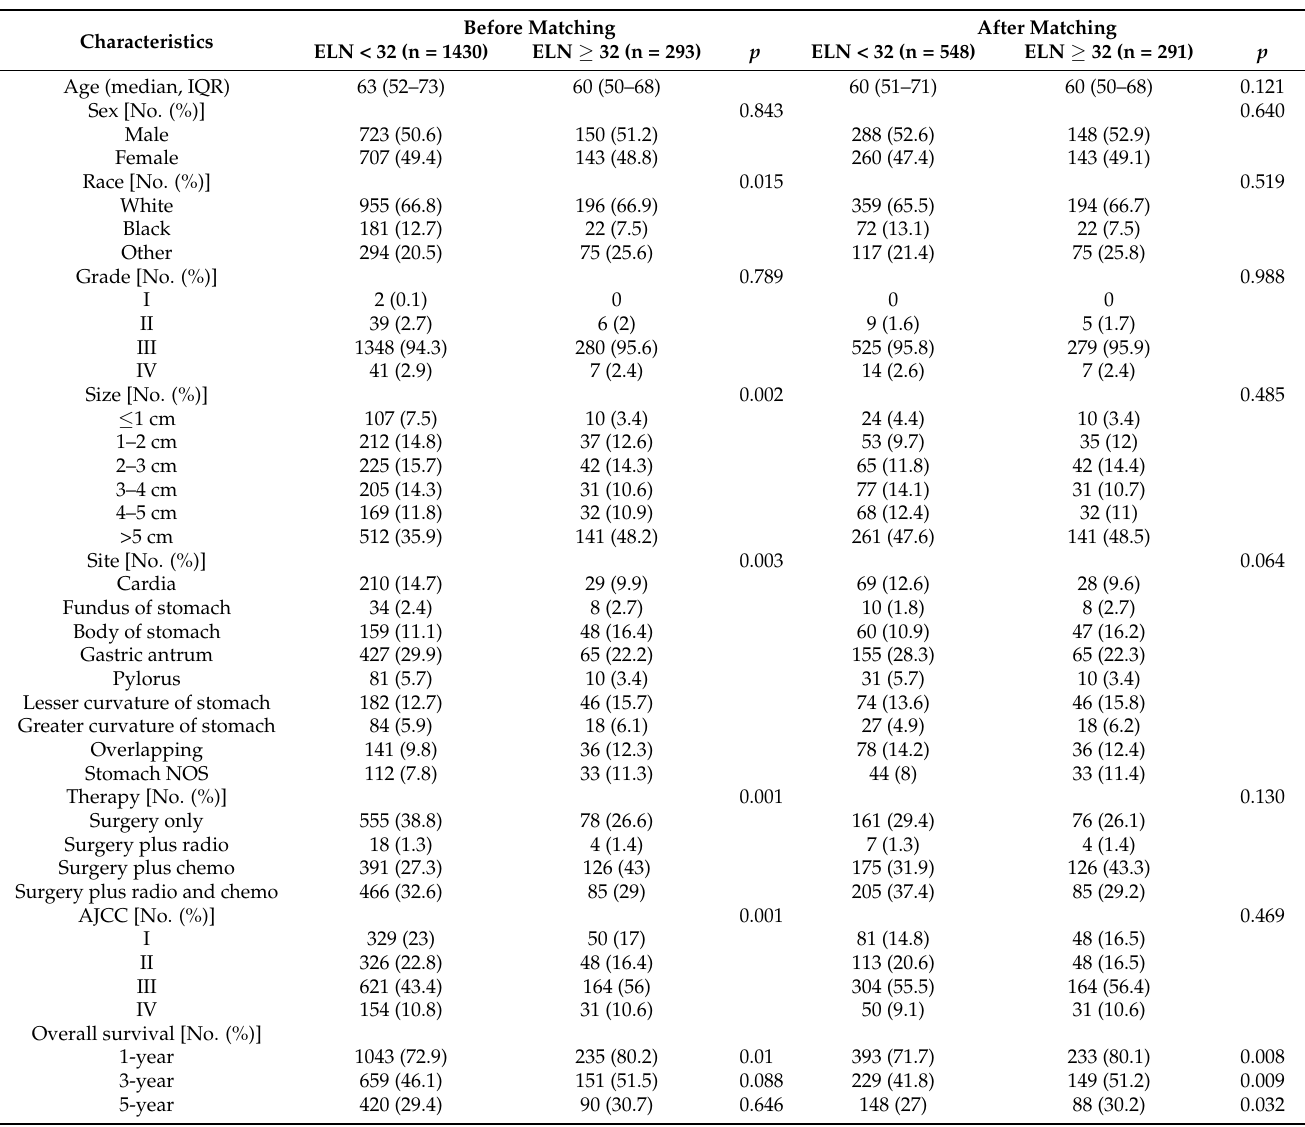
Table 3. Clinical characteristics of patients in the study before and after propensity score matching.